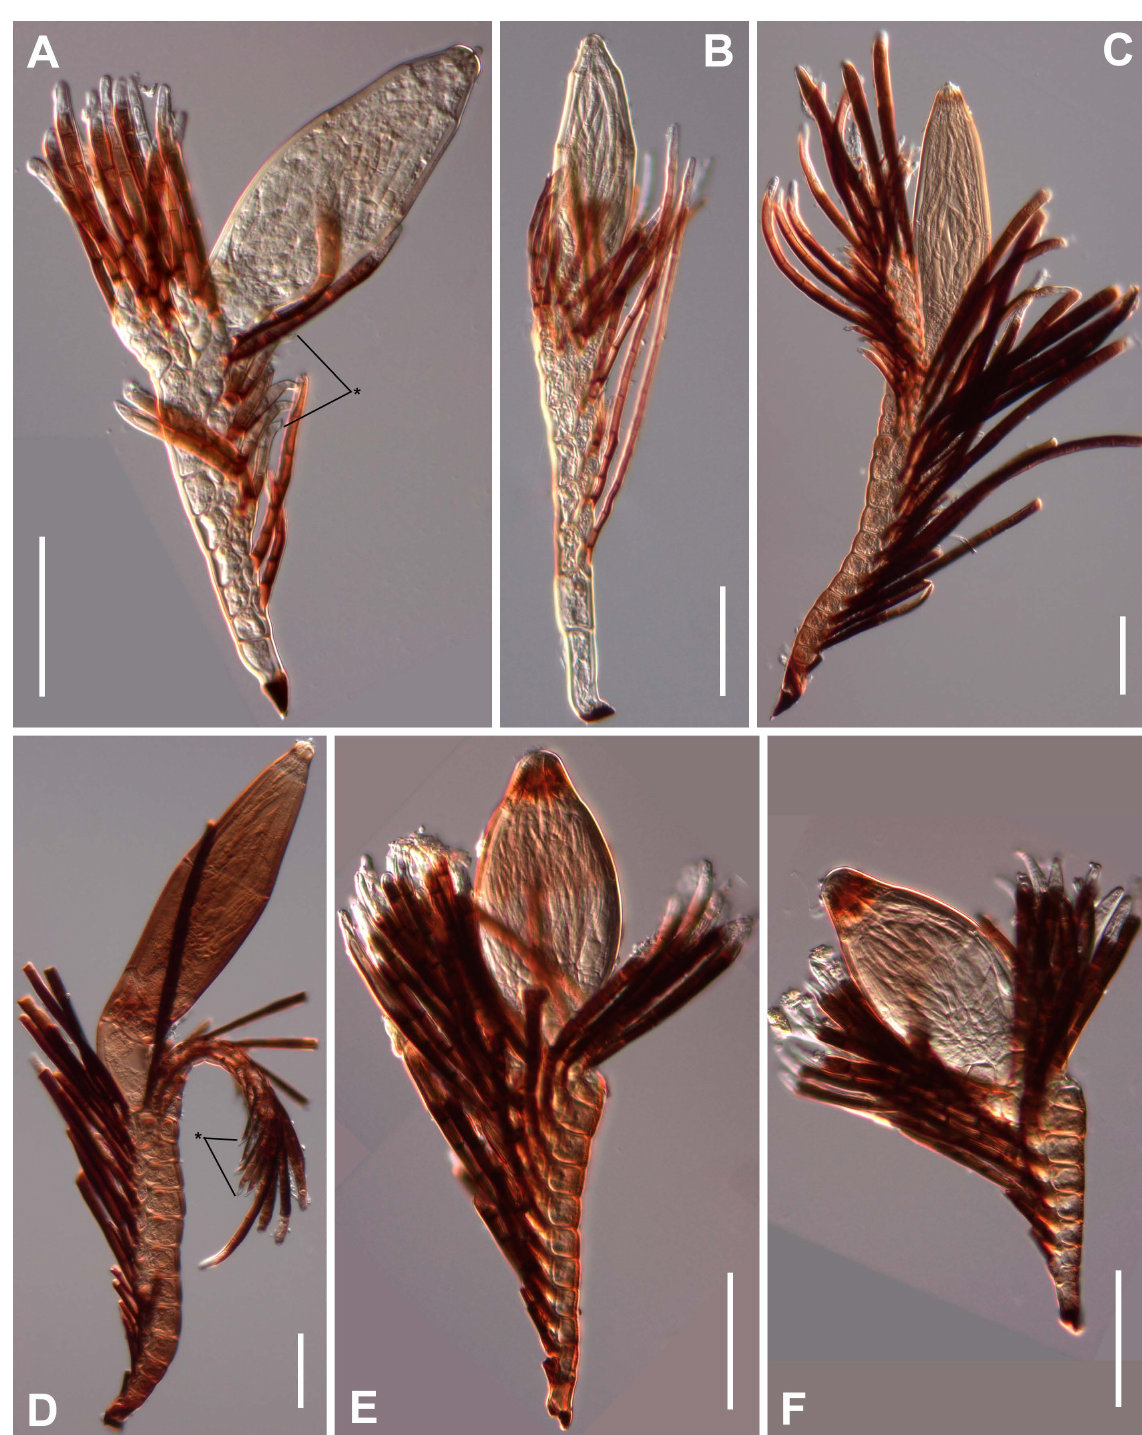
Fig. 17. Rhachomyces spp. A – B . R. canariensis Thaxt. Mature thalli from Trechus obtusus (A) and Epaphius secalis (B). Appendages type “c” are labelled in A (*). – C – D . R. furcatus (Thaxt.) Thaxt. Mature thalli with appendages of type “c” labelled in D (*). – E – F . R. lasiophorus (Thaxt.) Thaxt. Mature thalli. F . Short form from tarsi. Scale bars: 50 µm. Photographs from slides ZMUC C-F-122765 (A), ZMUC C-F-123438 (B), ZMUC C-F-122521 (C–D), ZMUC C-F-122906